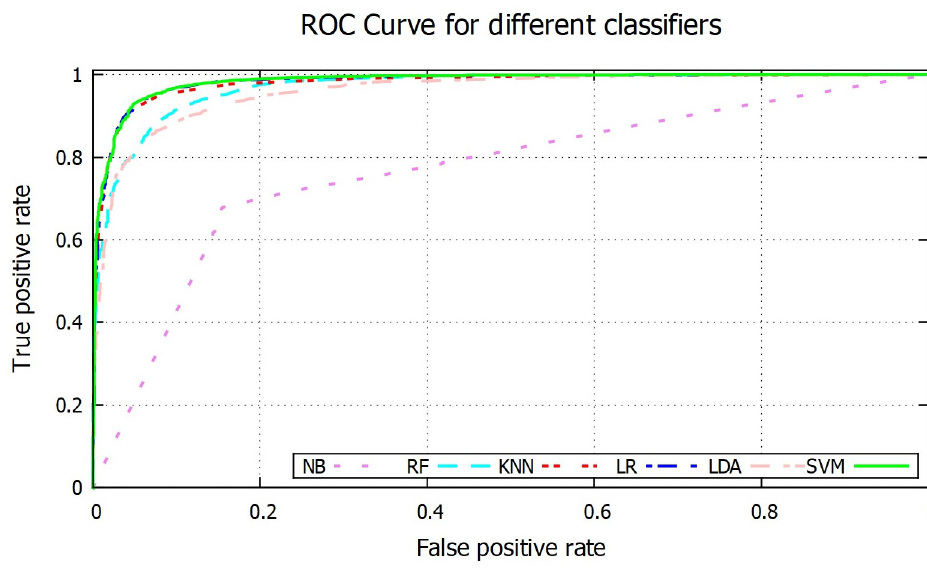
Fig 10. ROC graph for different ML based